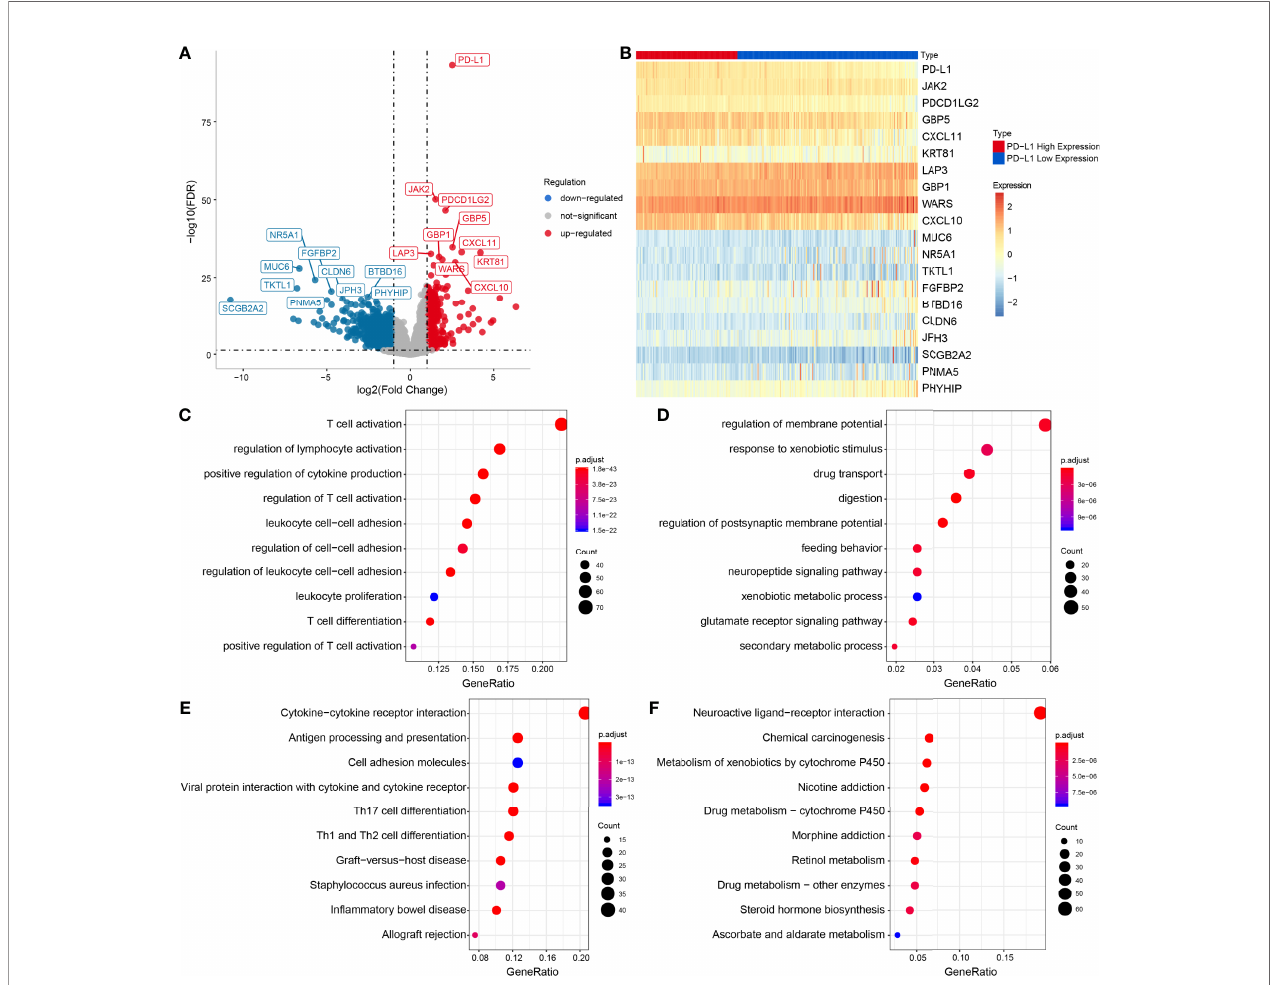
FIGURE 2 | Functional enrichment analysis of DEGs in PD-L1high and PD-L1low groups. (A) Volcanic map of DEGs. (B) Heat map showing top DEGs. Top 10 enriched GO terms in PD-L1 high (C) and PD-L1low group (D) . Top 10 signi fi cantly enriched KEGG pathways in PD-L1 high (E) and PD-L1low group (F)